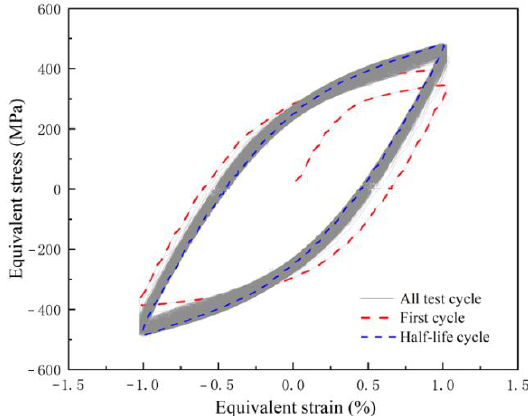
Figure 8. Hysteresis curve at 1% strain amplitude.